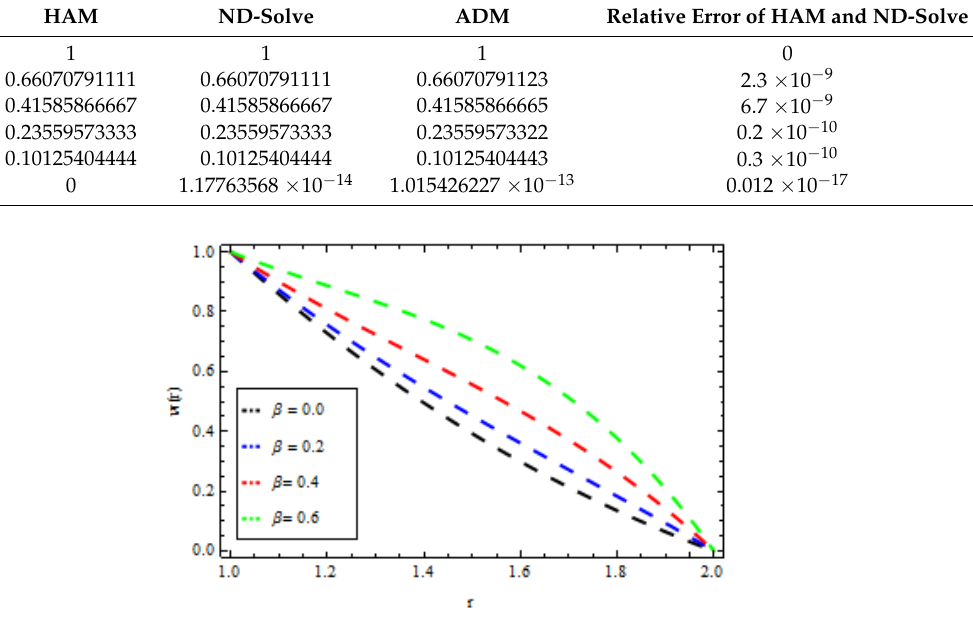
Figure 5. Velocity profile for various values of β when δ = 2, K = 0.1, M = 0.2.